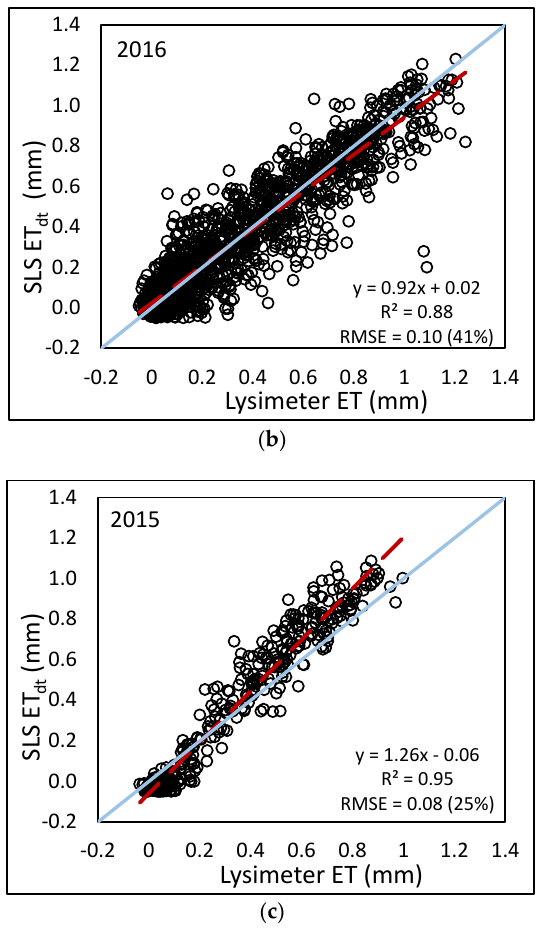
Figure 8. Comparison of hourly ET from SLS and lysimeter using ( a ) combined 2015-2016 data; ( b ) 2016 only; ( c ) 2015 only.